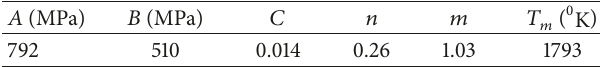
Table 4: Johnson-Cook properties of 4340 steel.